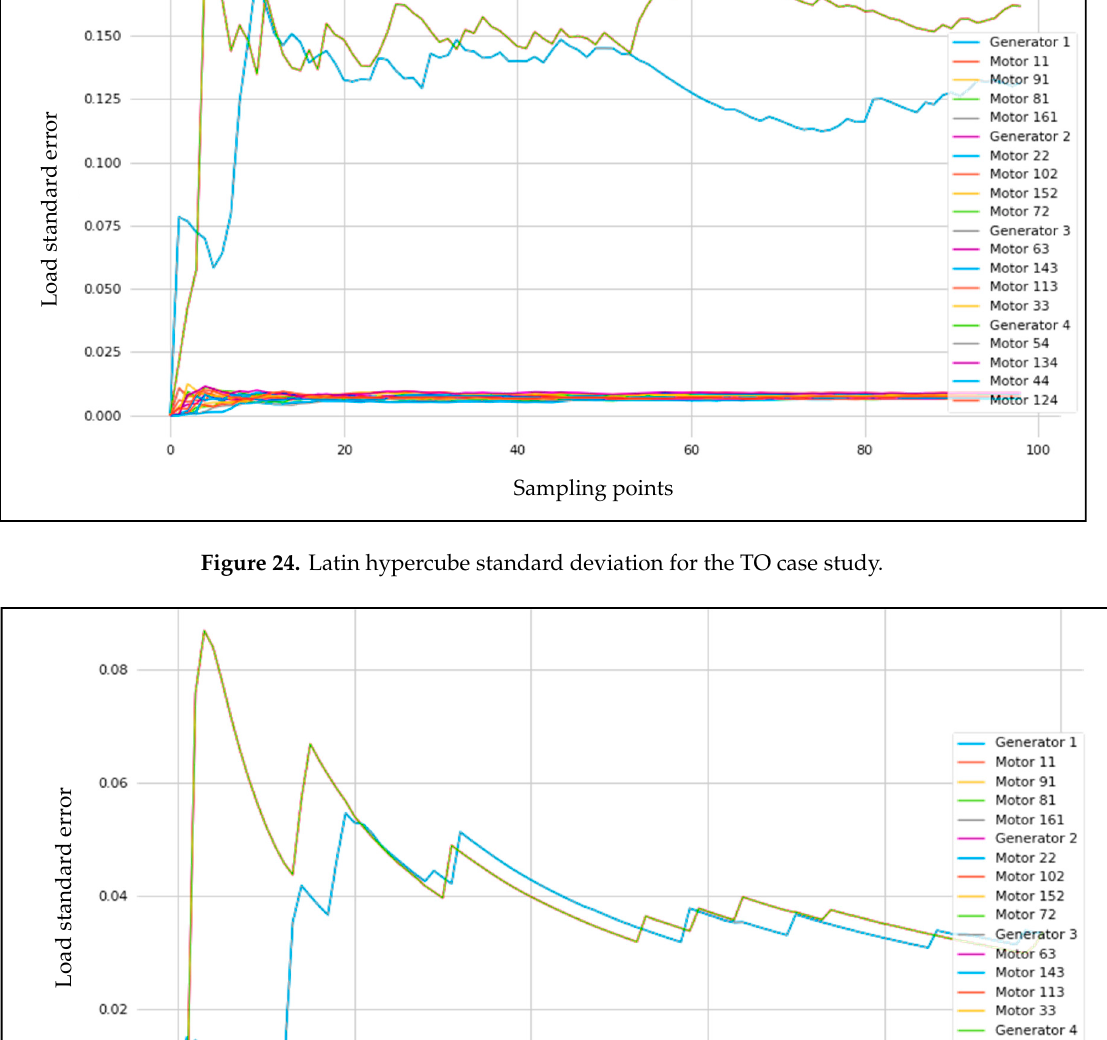
Figure 22. Monte Carlo standard deviation for the TO case study.